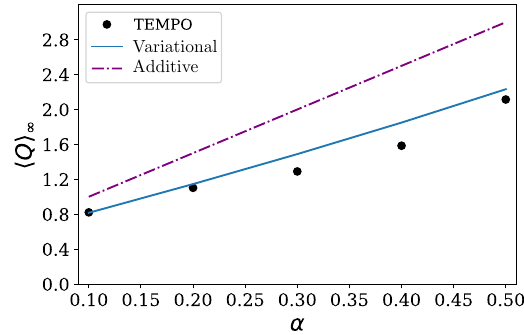
FIG. 7. Long-time limit of the heat transfer for the spin-boson model as a function of coupling strength, calculated using the path integral (circles), the additive theory (dash-dot line), and the variational method (solid line) for T =